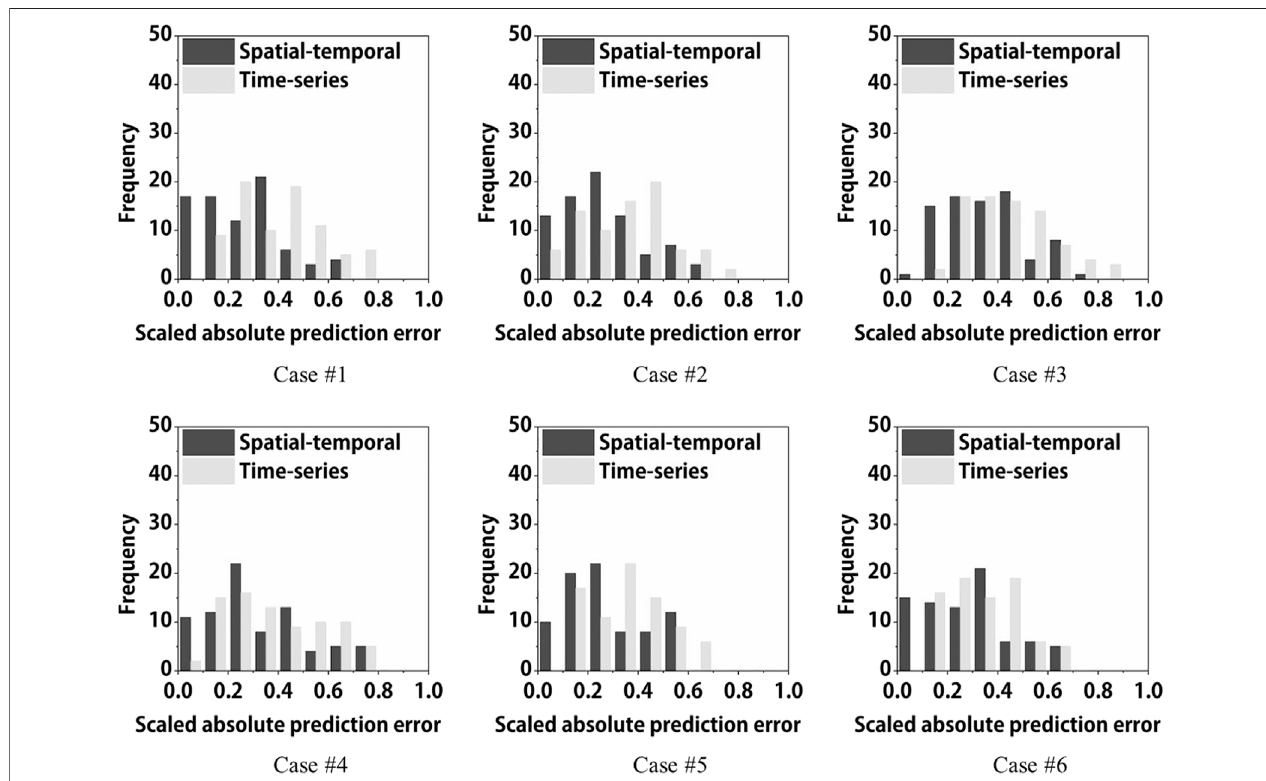
FIGURE 5 | Comparison of absolute prediction error between spatial-temporal model and conventional time-series model.